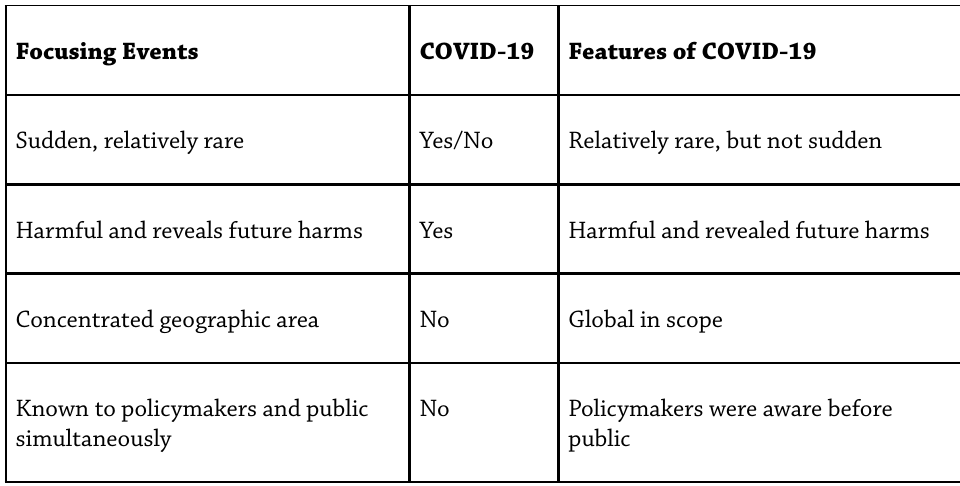
Table 3: Focusing Events and